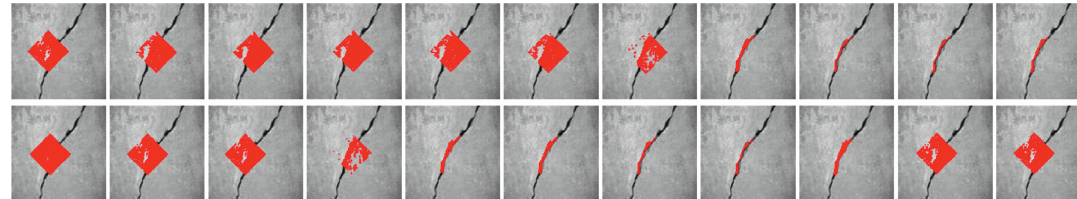
Figure 13: Percolated results using no strategies.